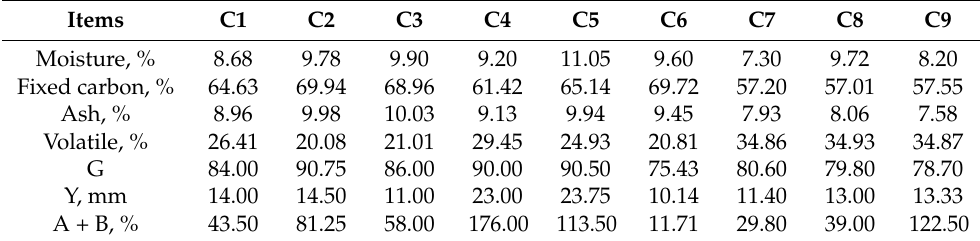
Table 1. Proximate analyses of the